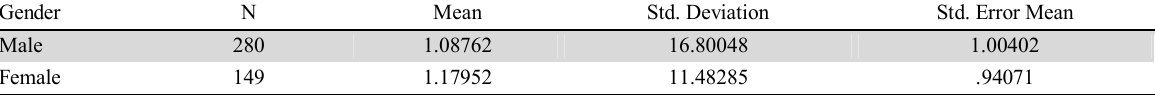
Levene's Test nces t-test for Equality of Means F Sig. t df